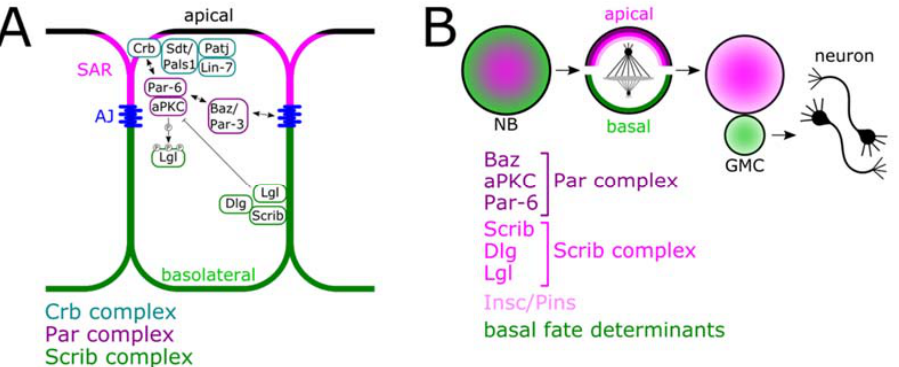
Figure 1. Overview of cell polarity determinants in Drosophila epithelia and neuroblasts. ( A ) Epithelial cells are polarized along the apicobasal axis. The Crb and Par complexes localize apically, and components of these complexes can interact with each other. In Drosophila , this region is referred to as the subapical region (SAR). In addition, Baz/Par-3 interacts with adherens junctions (AJ). The Par complex kinase aPKC phosphorylates Lgl, restricting the Scrib complex to the basolateral side of the cell, where it localizes cortically with the other members of the Scrib complex: Scrib and Dlg. At the basolateral side of the cell Lgl inhibits aPKC. ( B ) The Drosophila neuroblast (NB) is widely used as a model to study asymmetric stem cell division. Mitotic neuroblasts display apicobasal polarity. Components of the Par and Scrib complexes are apically localized. Further, Insc and its interactor Pins localize apically and orient the spindle apparatus. Neuroblast division results in two distinct daughter cells: the apical cell inherits apical determinants and maintains neuroblast fate. The basally formed cell, called ganglion mother cell (GMC), inherits basally localized differentiation factors and divides to produce